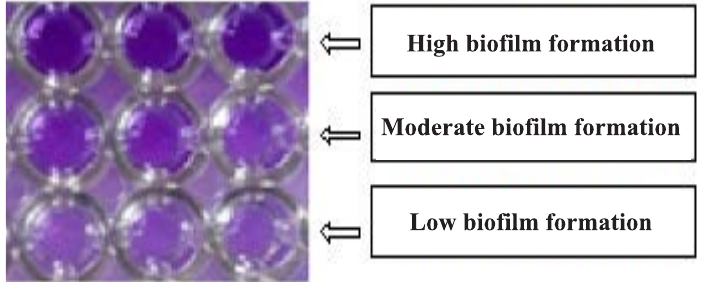
Fig. 3. Screening of biofilm producing ability of isolates by tissue culture plate method